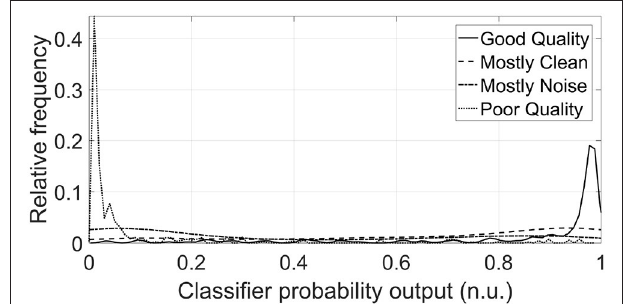
FIGURE 4 | Distributions of classifier probability outputs for DUS segments of test set for each of the four classes (n.u. stands for normalized units). The threshold of belonging to the Good class was fixed at 0.56 for the classifier. The majority of the distribution of the Good and Mostly Clean classes lies above this threshold, whereas the majority of Poor and Mostly Noise classes lies below this threshold, as was expected. The probability distributions were smoothed using a normal kernel function (Bowman and Azzalini,